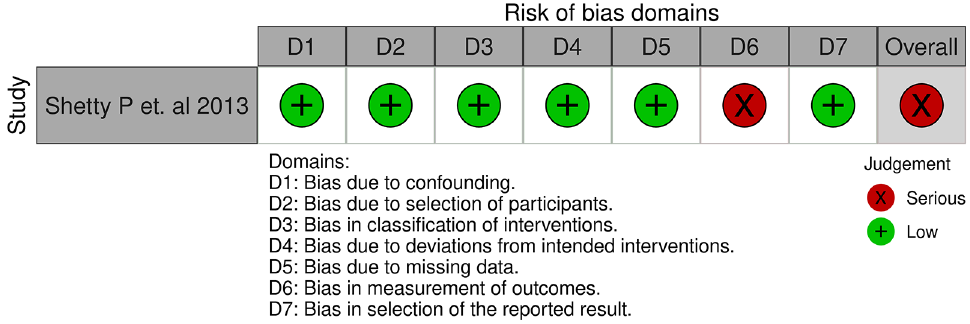
Fig. 3. Risk of bias assessment for non-randomized control trial done by ROBINS-I